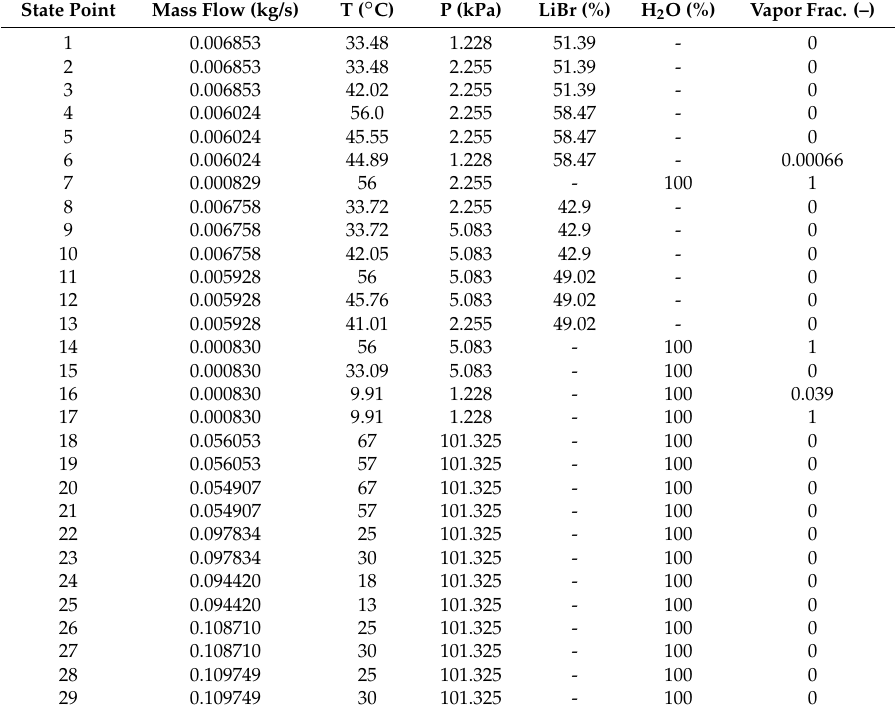
Table 6. The state point results calculated for the half-effect absorption chiller system that operates